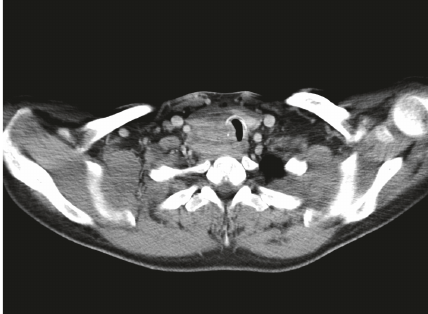
Figure 1: Neck CT scan showing the invasion of the trachea.